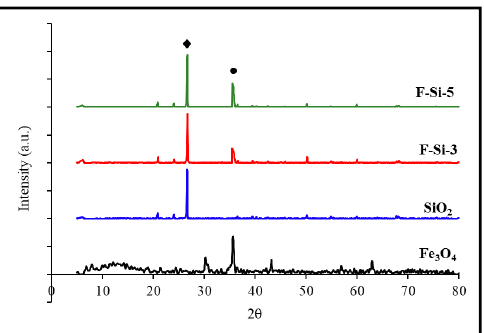
Figure 6. XRD patterns of Fe 3 O 4 nanoparticles, SiO 2 , and related SiO 2 nanocomposites calcined at 300 ° C and 500 ° C.